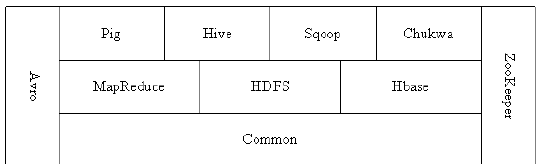
Figure 2: The structure of